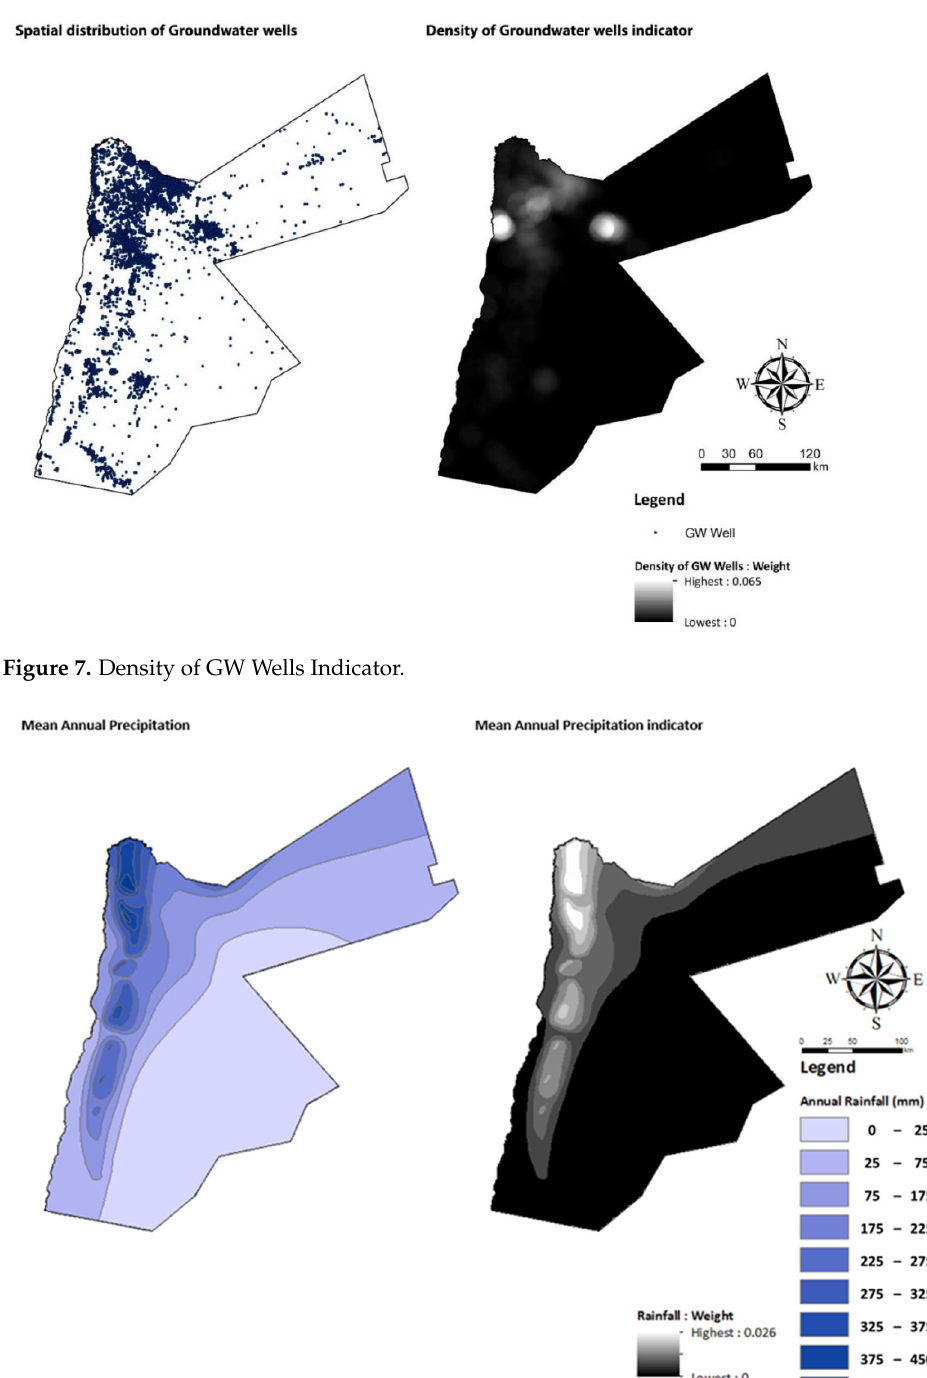
Figure 8. Precipitation Indicator.